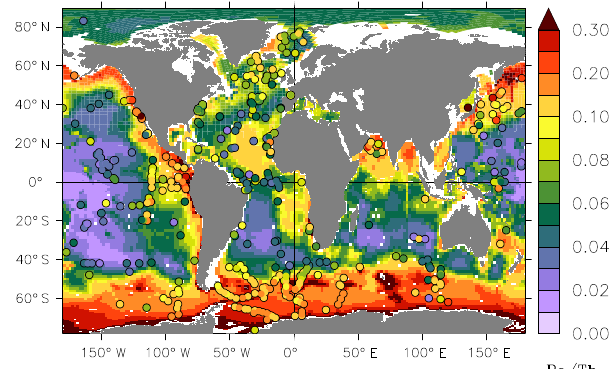
Figure 10. Sedimented 231 Pa / 230 Th ratio. Top core measurements are presented as coloured discs. This is the standard simulation with = 1. /K Th , bSiO K Pa , bSiO 2 2